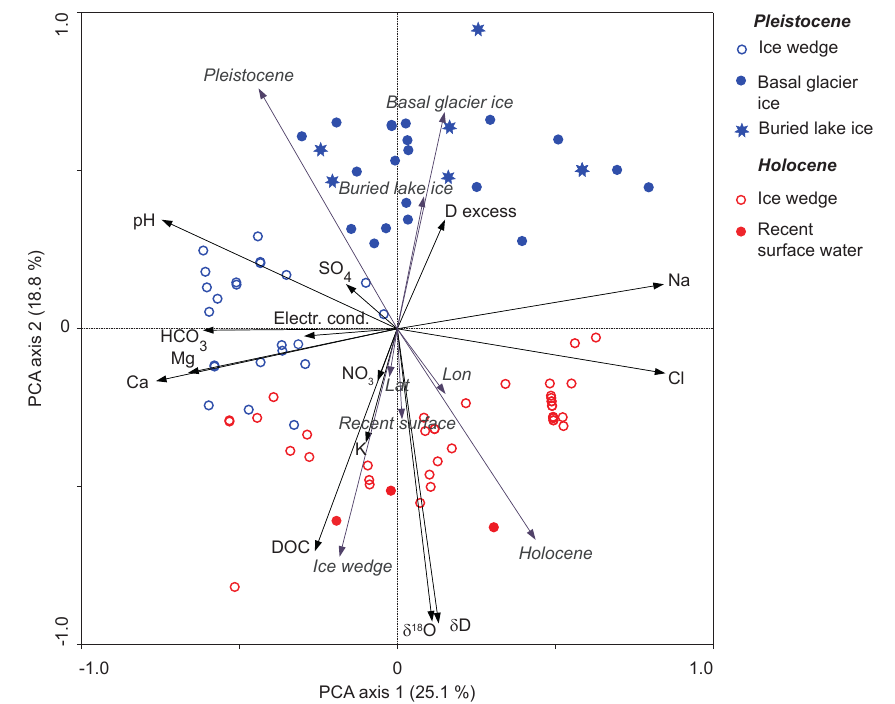
Figure 5. PCA biplot for ground-ice data. Inactive supplementary parameters (i.e., ice wedge, buried lake ice, basal glacier ice, snowpack ice, surface water, Pleistocene, Holocene, recent) are shown in grey italic. For individual sample values see Table